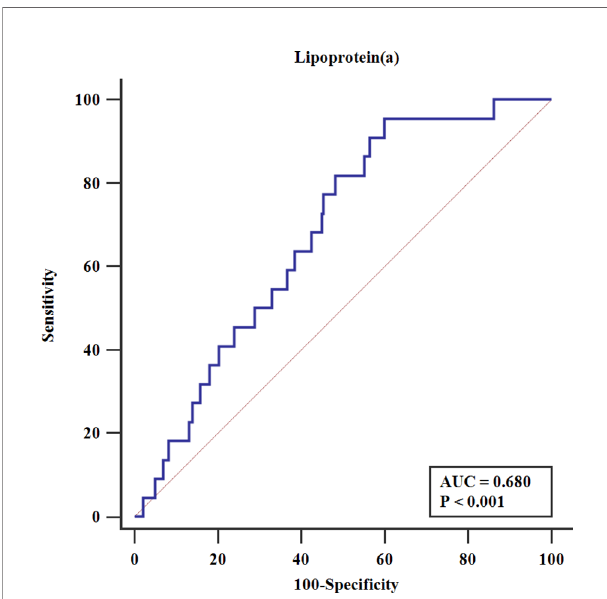
FIGURE 2 | Receiver-operating characteristics analysis. AUC, the area under the receiver-operating curve.